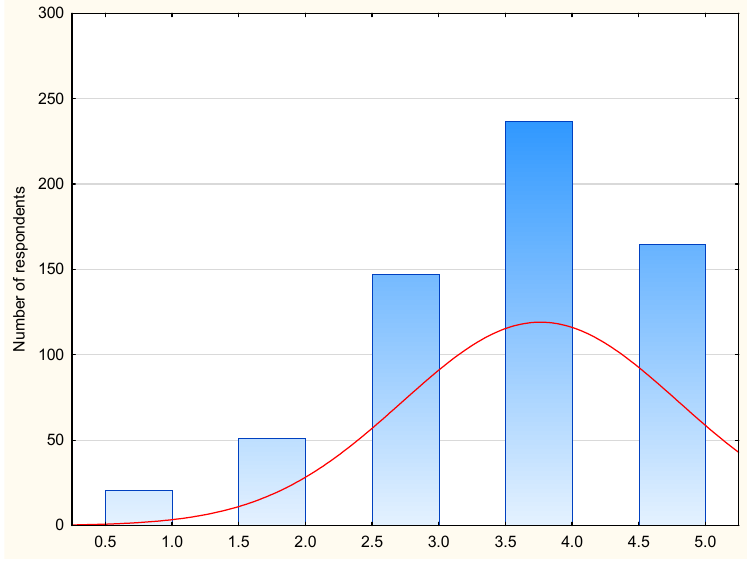
Figure 7. Histogram of the ease of class content acquisition from traditional learning.